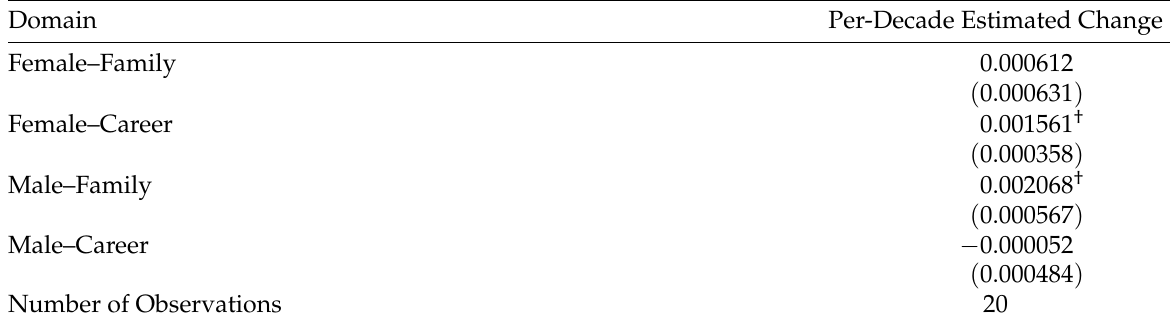
Table 3: Linear regression model of male gender bias over decade by